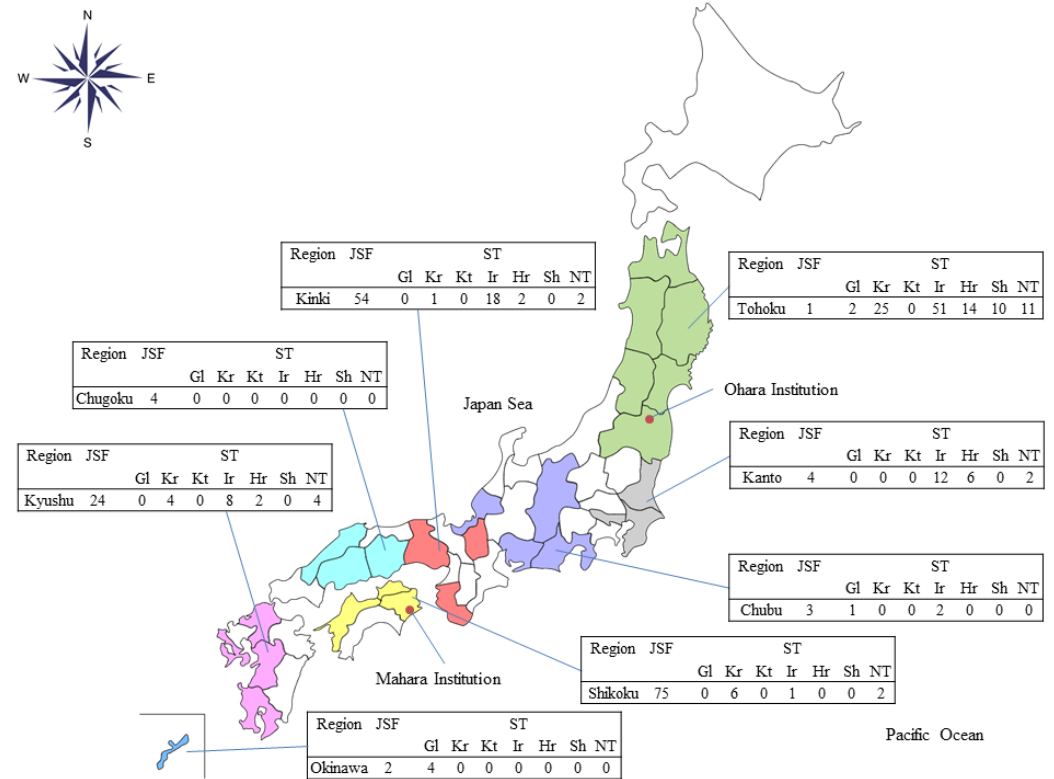
Figure 3. The number of cases serologically diagnosed as Japanese spotted fever or scrub typhus (serotypes) in each Japanese region at the reference centers. Abbreviation: JSF, Japanese spotted fever; ST, scrub typhus; Gl, Gilliam; Kr, Karp; Kt, Kato; Ir, Irie/Kawasaki; Hr, Hirano/Kuroki; Sh, Shimokoshi;